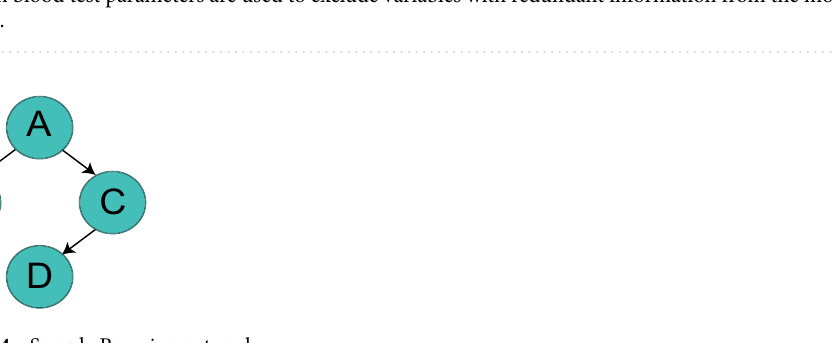
Figure 4. Sample Bayesian